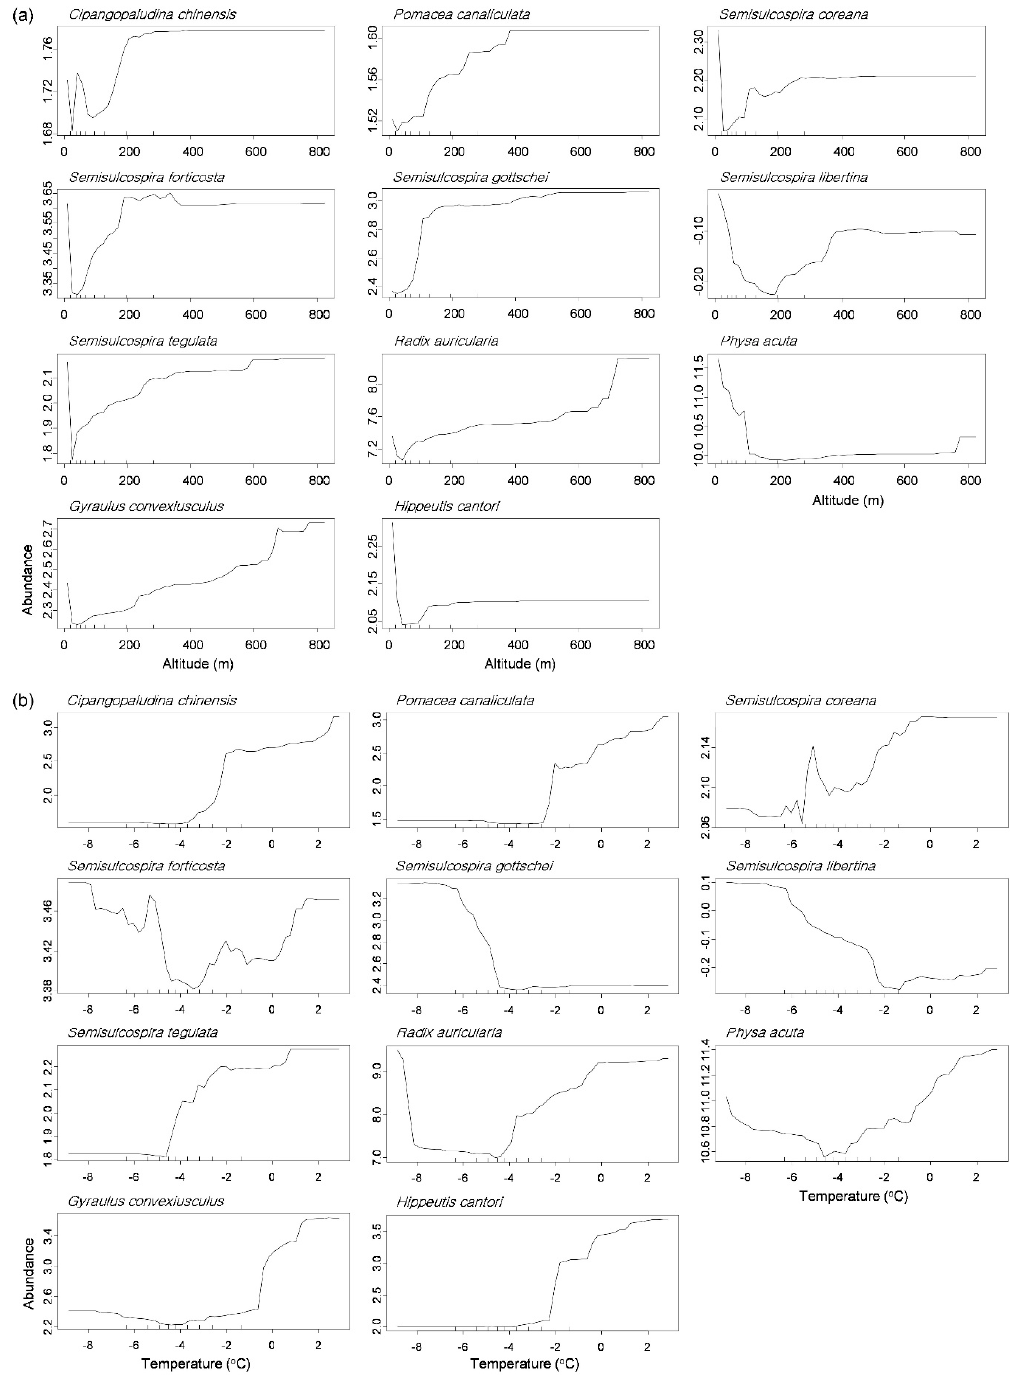
Figure 5. Partial dependence plots of 11 abundant species responding to altitude ( a ) and average temperature in January ( b ) in the random forest model.